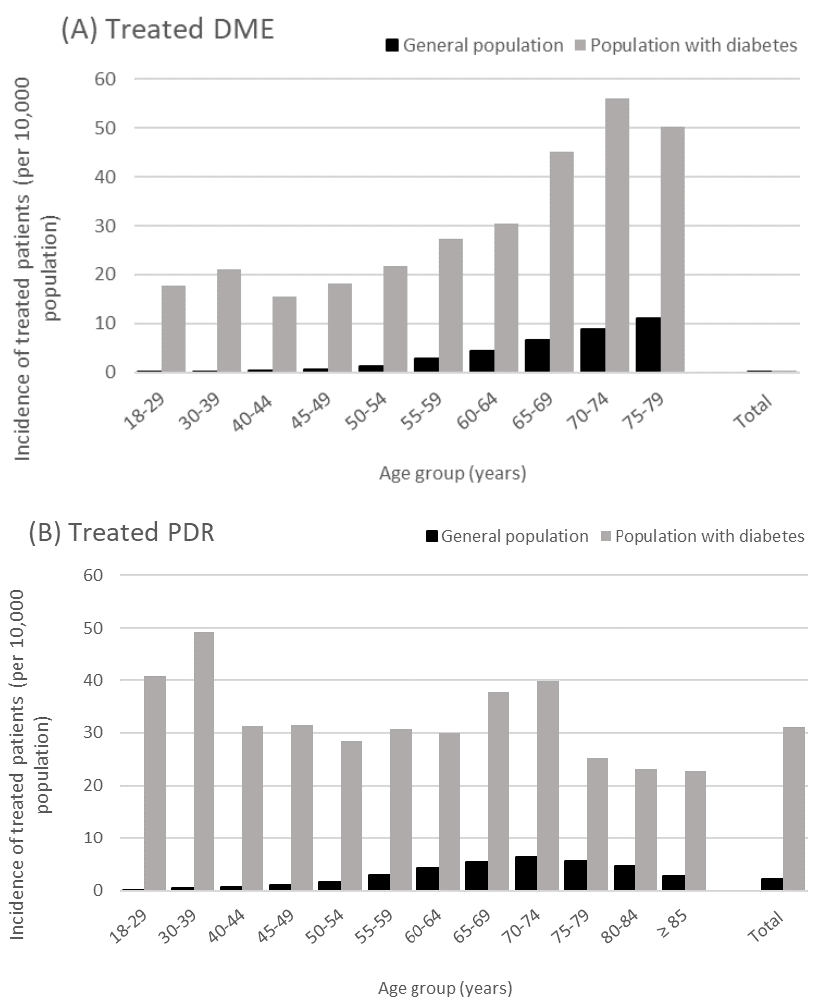
Figure 2. Treated DME ( A ) and PDR ( B ) incidence in 2018 per age category in the French general population and in the diabetic population. Abbreviations: DME = diabetic macular edema, PDR = proliferative diabetic retinopathy.